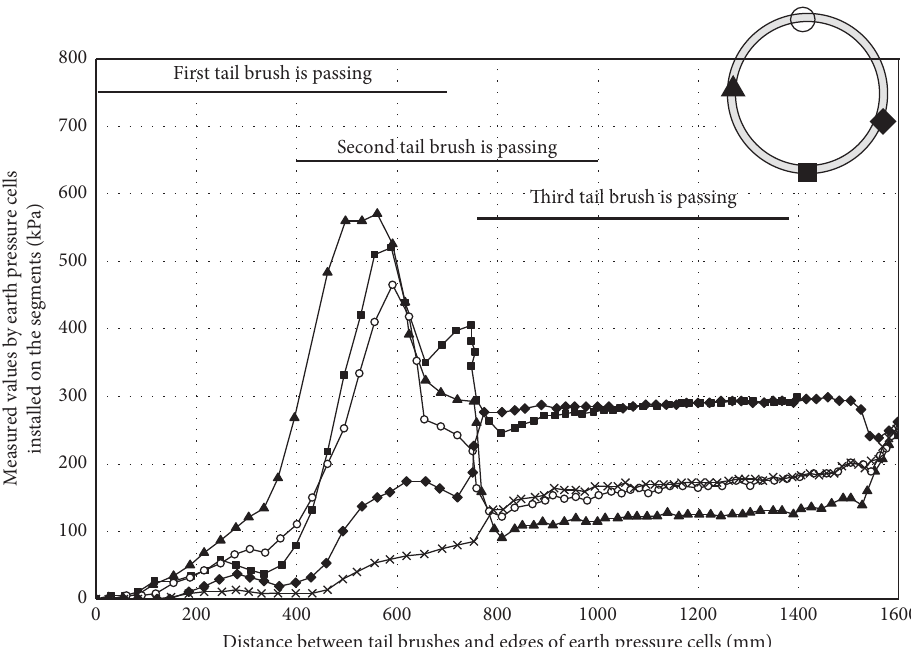
Figure 9: Relationship between the observed and theoretical